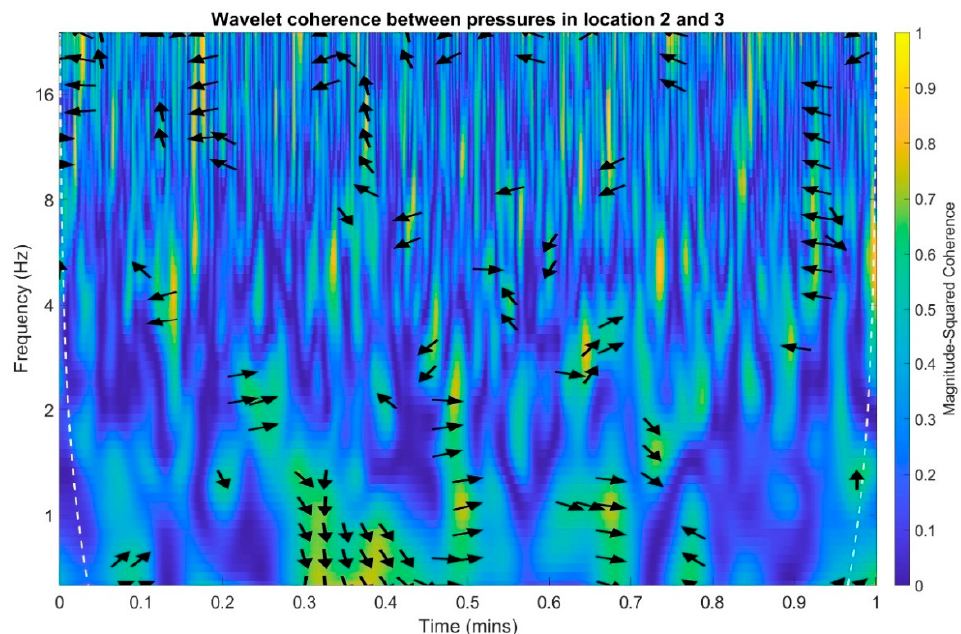
Figure 25. Wavelet coherence between acoustic pressures of infrasound measured in locations 2 and 3. For examples arrow pointing to the right indicate that pressure in location one and pressure in the location two are positively correlated. Arrows pointing to the left indicate that pressures in the location one and two are negatively correlated. The straight up arrow implies that pressure in location one is leading in respect to location two. The straight down arrow imply that the pressure in location one is lagging in respect to pressure in location two (Figure